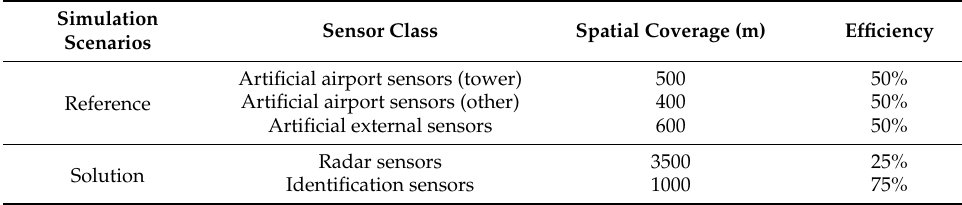
Table 1. Parameter values of the counter-drone sensing entities.